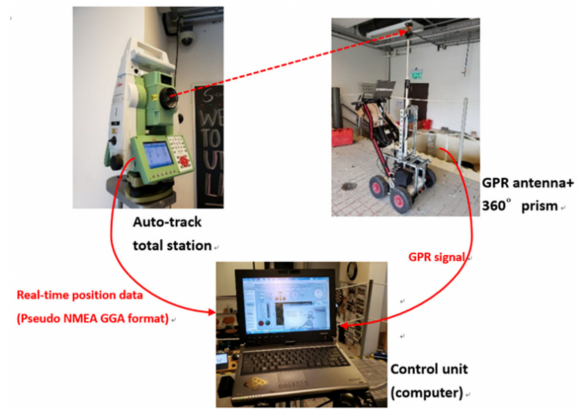
Figure 7. Main instrumentation used in this study and data flow.